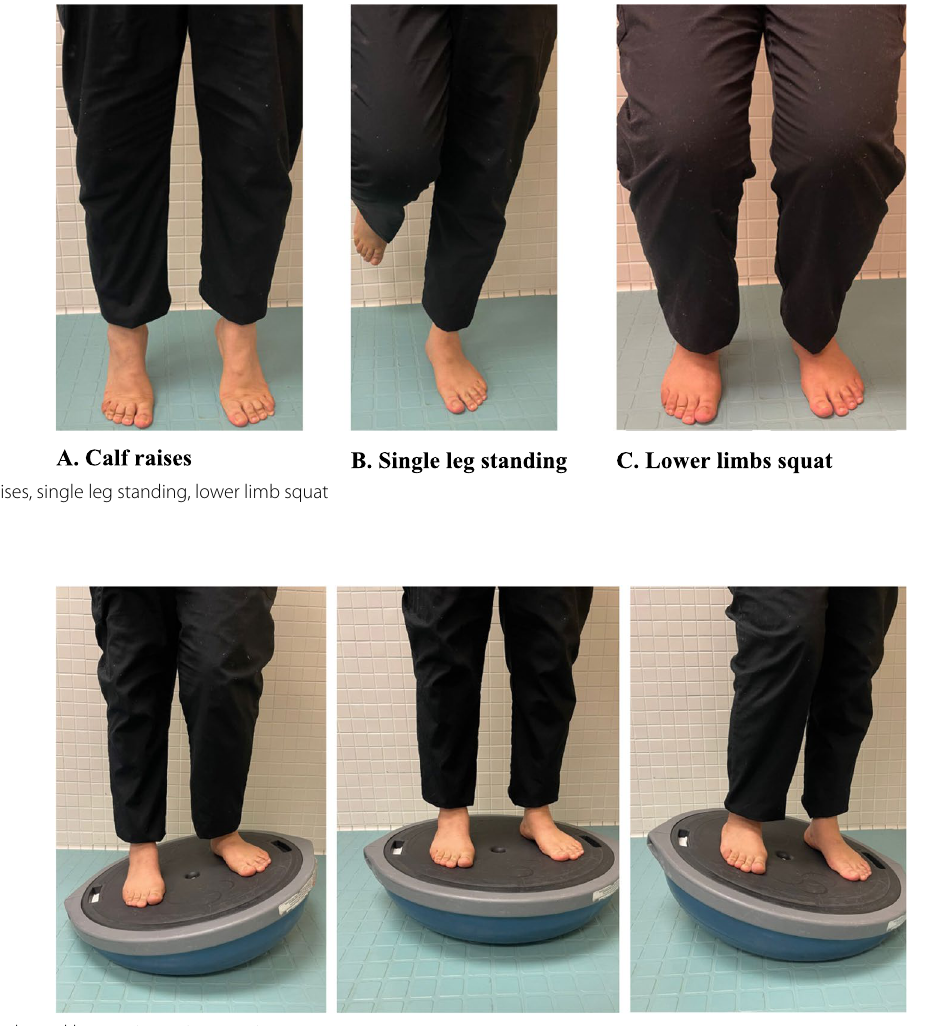
Fig. 4 Double leg ankle proprioceptive exercises